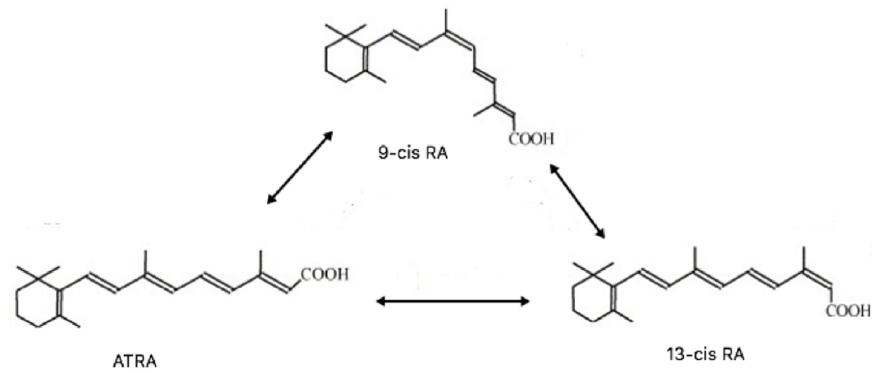
Figure 1. Retinoic Acids (RA) stereoisomers.